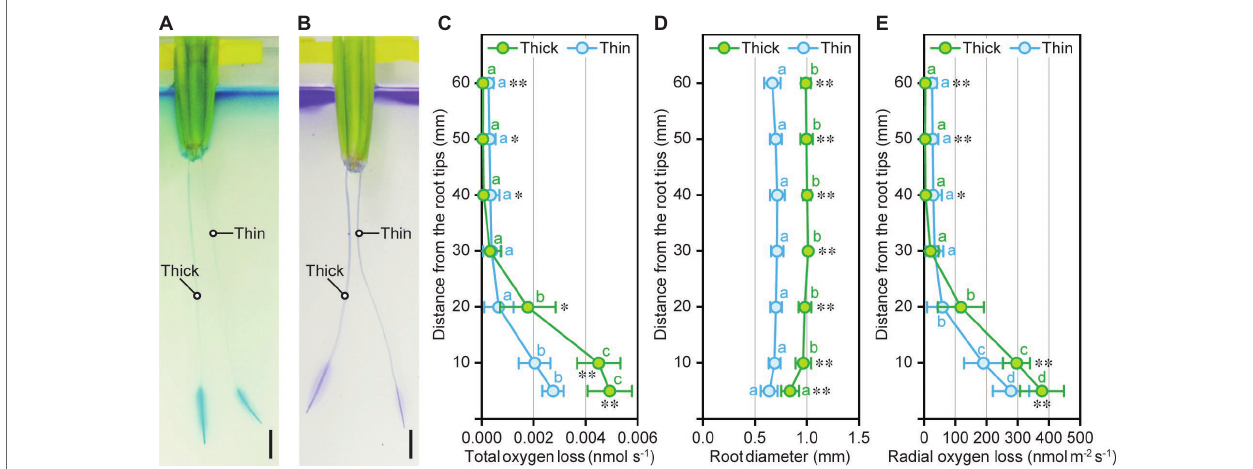
FIGURE 5 | Oxygen movement in thick and thin adventitious roots of rice. Methylene blue staining (A) and crystal violet staining (B) of thick and thin adventitious roots of rice seedlings under stagnant conditions. Bars = 10 mm. Total oxygen loss from adventitious roots (C) , adventitious root diameter (D) , and radial oxygen loss (ROL) from adventitious roots (E) at 5, 10, 20, 30, 40, 50, and 60 mm from the tips of thick and thin adventitious roots of rice seedlings under stagnant conditions. Nine-day-old rice seedlings were further grown under stagnant conditions for 14 days. Significant differences between thick and thin roots at p < 0.01 and p < 0.05 (two-sample t -test) are denoted by ∗∗ and ∗ , respectively. Different lowercase letters denote significant differences among different positions of roots ( p < 0.05, one-way ANOVA and then Tukey’s test for multiple comparisons). Values are means ± SD ( n =